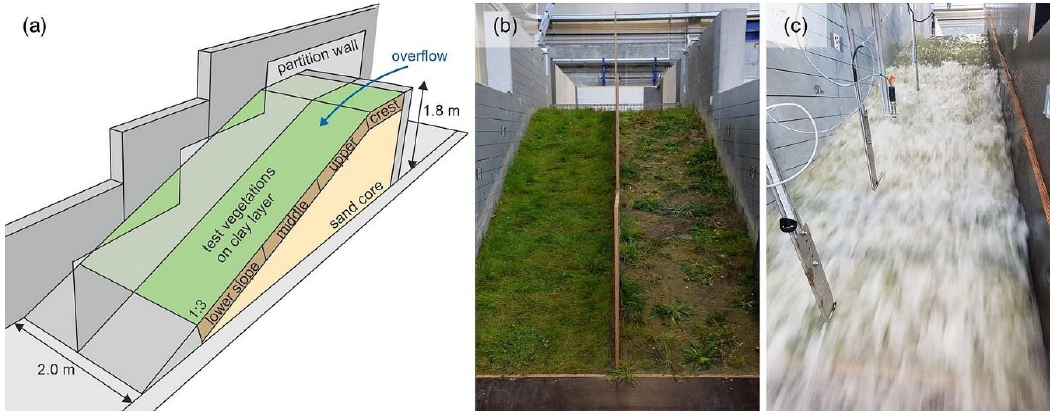
Figure 4. ( a ) Schematic sketch of the overflow test setup, ( b ) photo of the dike model with test vegetation TV1 (left) and TV6 (right) (view from toe of the dike) (photo: Holle, 2018), and ( c ) measuring instrumentation during tests (view from toe of the dike).